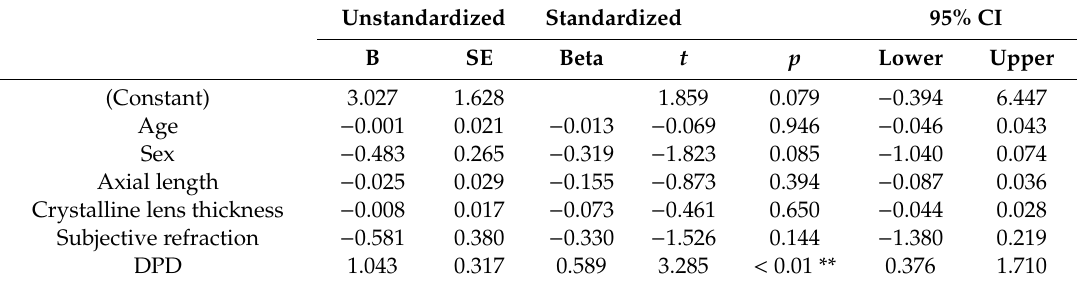
Table 6. Multiple regression analysis in the older group (45–62 years old, n = 25 and adjusted R 2 =